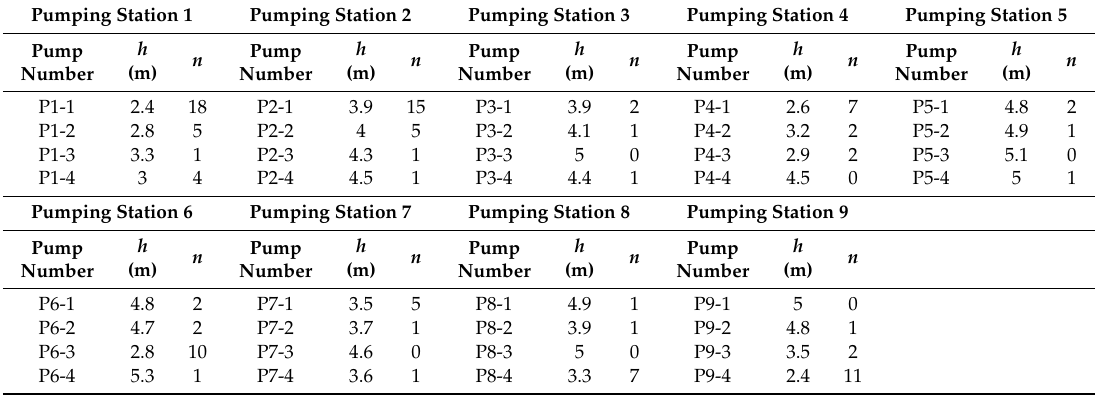
Figure 8. Comparison of two optimization methods: ( a ) comparison of the number of pump start-up/shutoff times; ( b ) comparison of pump operating time. 7.21 means rainfall event on July 21, 2012; 7.30 means rainfall event on July 30, 2012; 6.24 means rainfall event on June 24, 2012. Table 4. Results of multistage pumping station optimization method for twenty-year recurrence period. Table 3. Pump operation results using the three methods. N is the total number of pump start-up/shutoff times; T is the total pump operating time (unit: min); 7.21 means rainfall event on July 21, 2012; 7.30 means rainfall event on July 30, 2012; 6.24 means rainfall event on June 24, 2012.